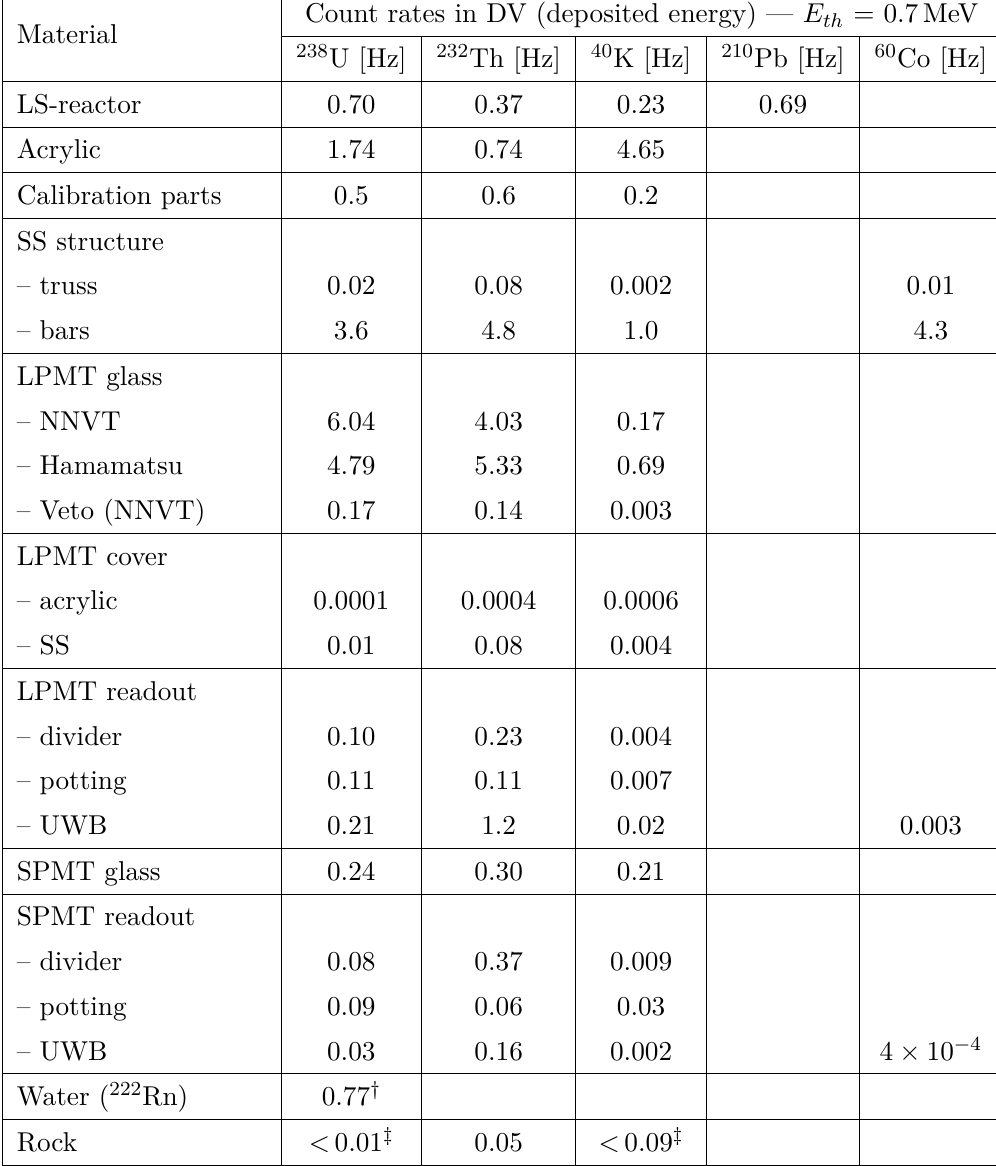
Table 3. Background count rates in detector volume (DV) in the energy range between 0.7 MeV and 12 MeV induced by the various detector components with the contaminant concentrations of table 1. The results are given for each contaminant separately, for a complete picture. Only the deposited energy is considered in these results, i.e. no optical propagation nor detector energy resolution were